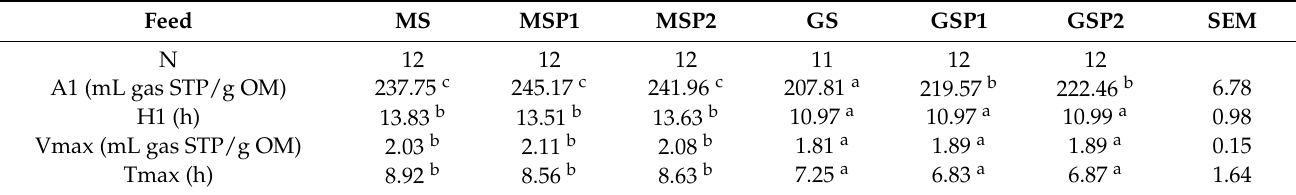
Table 5. Fitted curve parameters (pooled data from 2 laboratories).